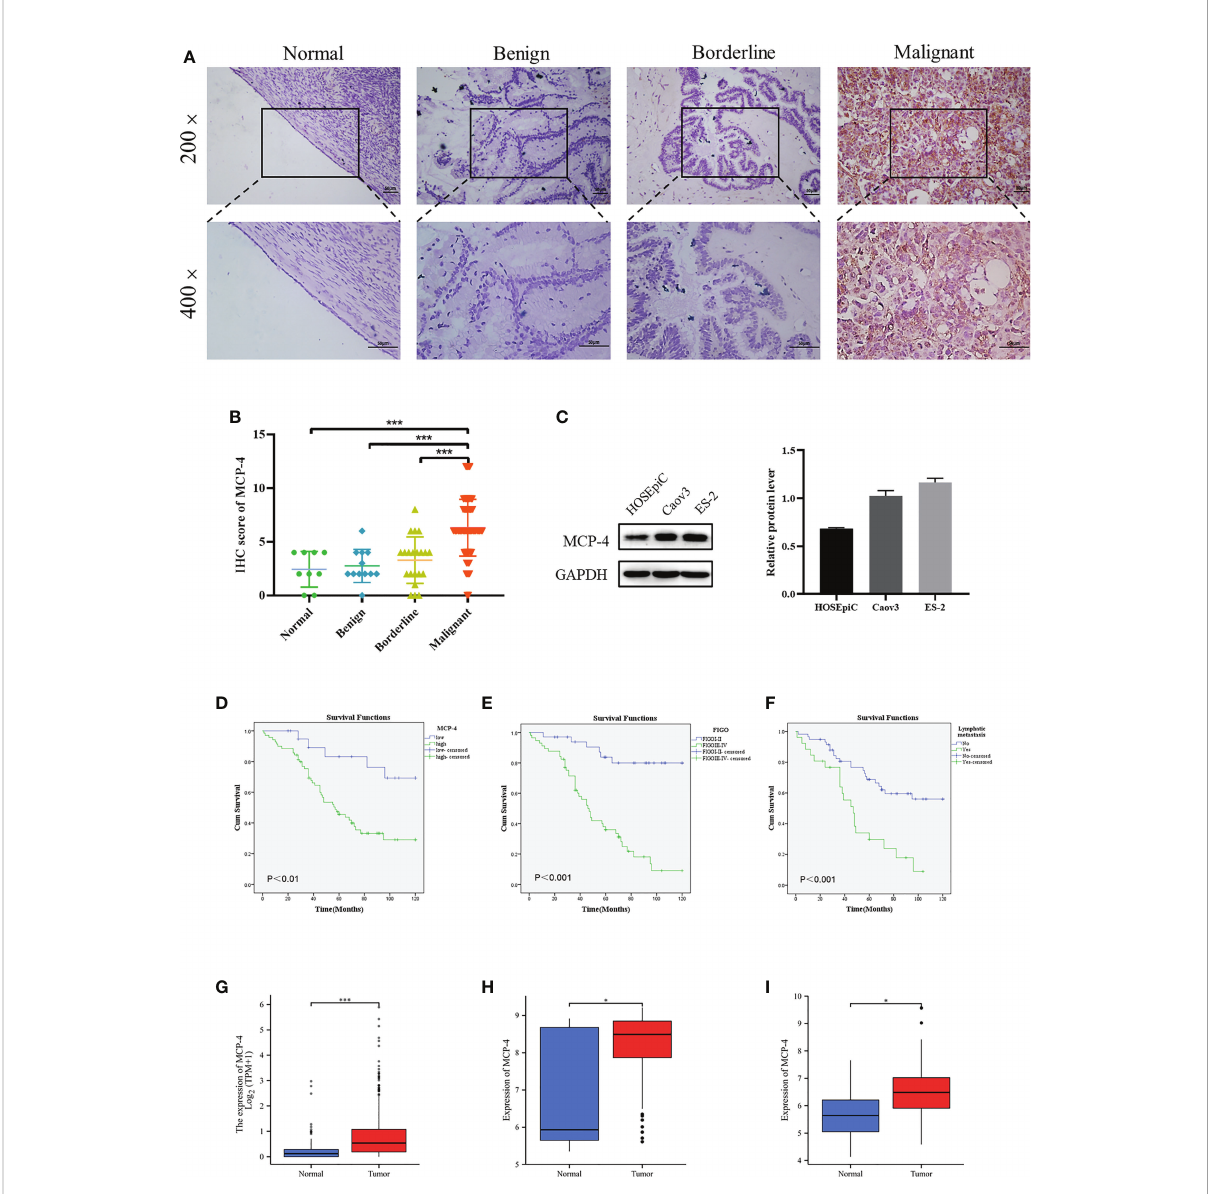
FIGURE 1 High MCP-4 expression in patients with ovarian cancer associated with poor prognosis. (A) MCP-4 expression in ovarian tissue samples (×200 and ×400, scale bar = 50 µm): ovarian normal tissue (n = 9), ovarian benign tumor (n = 12), ovarian borderline tumor (n = 21), ovarian malignant tumor (n = 105). (B) Immunostaining scores of MCP-4 in normal ovarian tissues, benign, borderline, and malignant tumors. (C) Representative images and quantitation of the western blotting showed that the protein expression of MCP-4 in the normal ovary epithelial cells (HOSEpiC) and ovarian cancer cell lines (Caov3 and ES-2) (n = 3). GAPDH was used as an internal control. (D – F) Overall survival analysis according to MCP-4 expression, FIGO stage and lymphnode metastasis. Box plots show MCP-4 mRNA expression in the normal tissues (blue plot) and ovarian tumor (red plot) from TCGA database (G) , GSE18520 datasets (H) , and GSE38666 datasets (I) . Data are presented as mean ± SD. * P < 0.05; *** P <